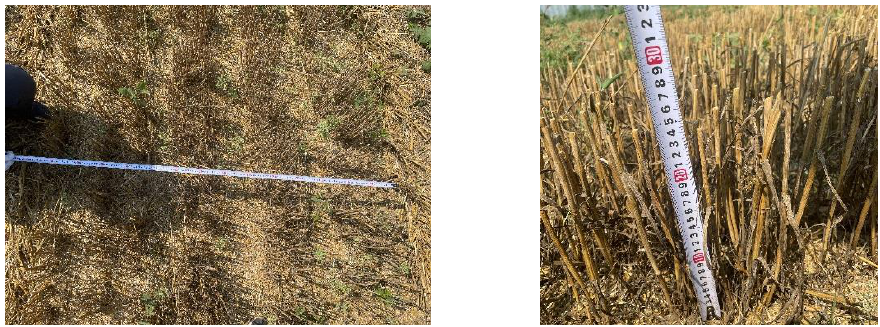
Figure 10. Experiment field covered with wheat straw before maize sowing.